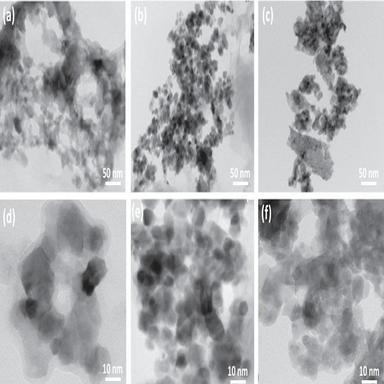
The TEM images at different magnifications of p MgO-Y2O3 nanocomposite at different Mg2+ ion content (a and d) for 80 Mg:20Y sample, (b and e) for 50 Mg:50Y sample and (c and f) for 20 Mg:80Y sample calcined at 600 C for 2 h.